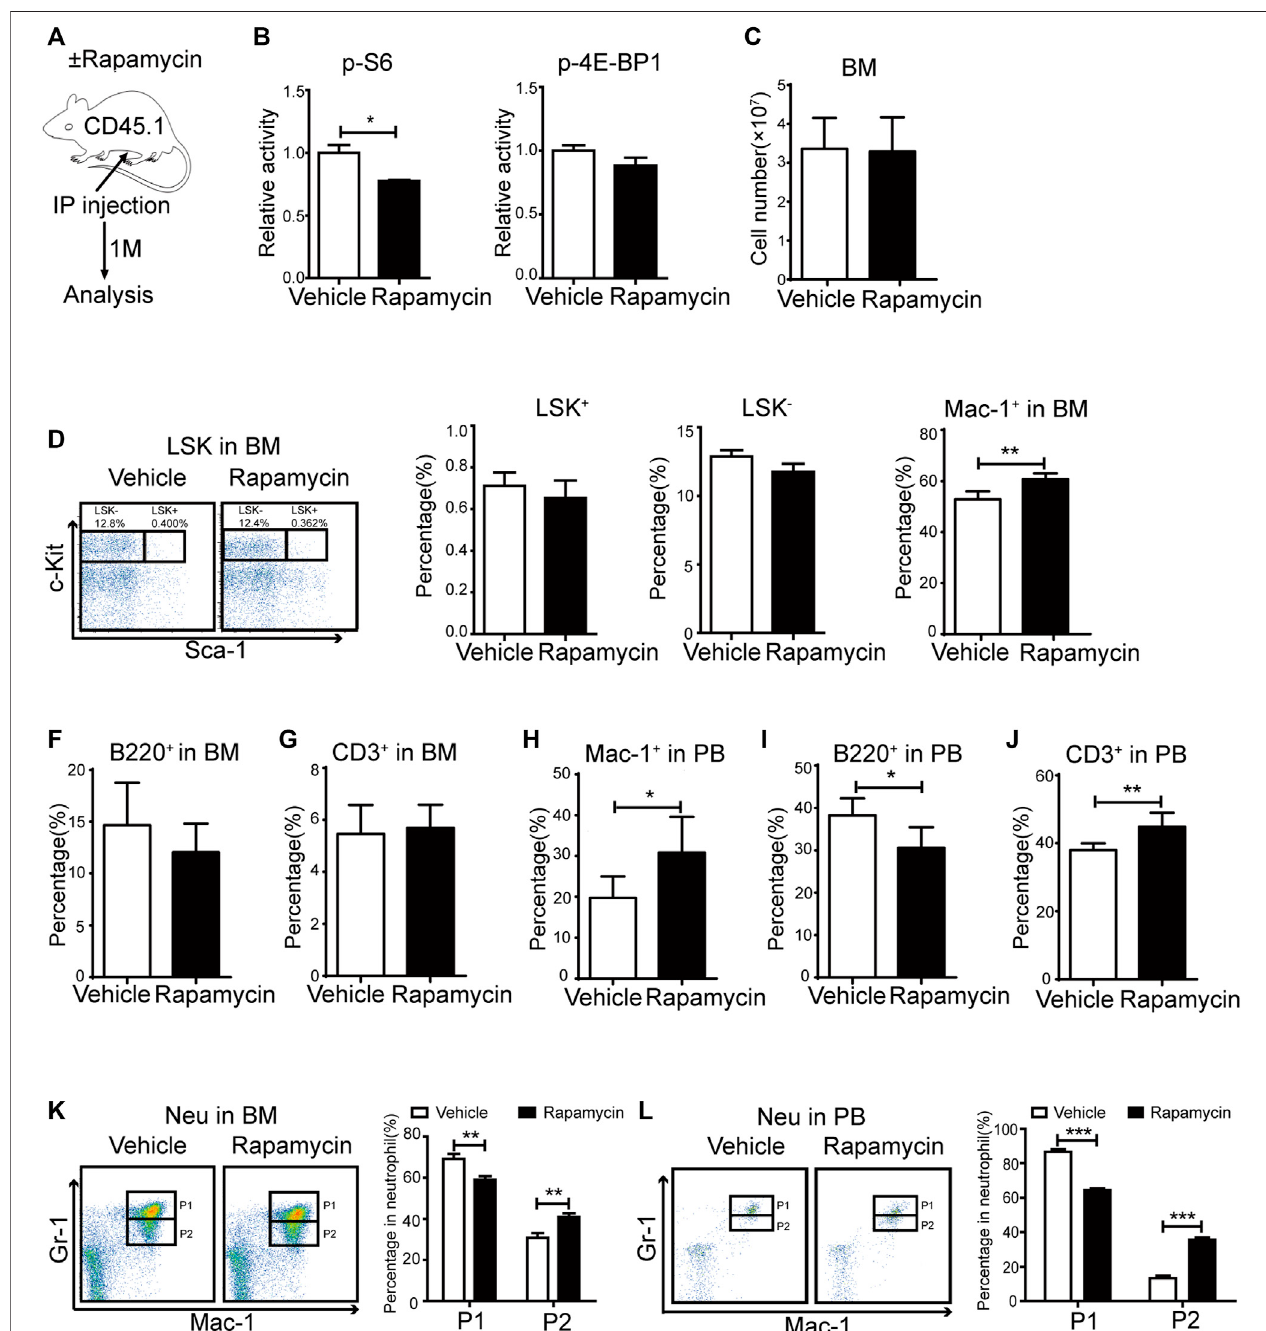
FIGURE1| Intraperitonealadministrationofrapamycinenhancedmyeloidcellsproliferation (A) Experimentdesignfollowingrapamycinorvehicletreatment,n=4,days=30, dose= 4 mg/kg/day (B) Fluorescence intensity ofp-S6 and p-4E-BP1 in bonemarrow (C) Absolute number ofbonemarrow cells (D) FACS analysis ofLSK + (Lin - c-Kit + Sca-1 + ) andLSK - (Lin - c-Kit + Sca-1 - )cellsinBM(leftpanel).PercentageofLSK + andLSK - inBMofmicethatinjectedwithrapamycinorvehicle(rightpanel) (E – G) Percentageofmyeloidcells (CD11b + ), B cells (B220 + ), T cells (CD3 + ) by FACS in BM in two groups (H – J) Percentage of myeloid cells (CD11b + ), B cells (B220 + ), T cells (CD3 + ) by FACS in PB in two groups (K) FACSanalysisofneutrophilsinBMofmicetreatedbyrapamycinorvehicle,n=4(leftpanel).Percentageofneutrophilsubpopulationsintwogroups;n=4(rightpanel) (L) FACS analysis of neutrophils in PB of mice treated by rapamycin or vehicle, n = 4 (left panel). Percentage of neutrophil subpopulations in two groups, n = 4 (right panel).